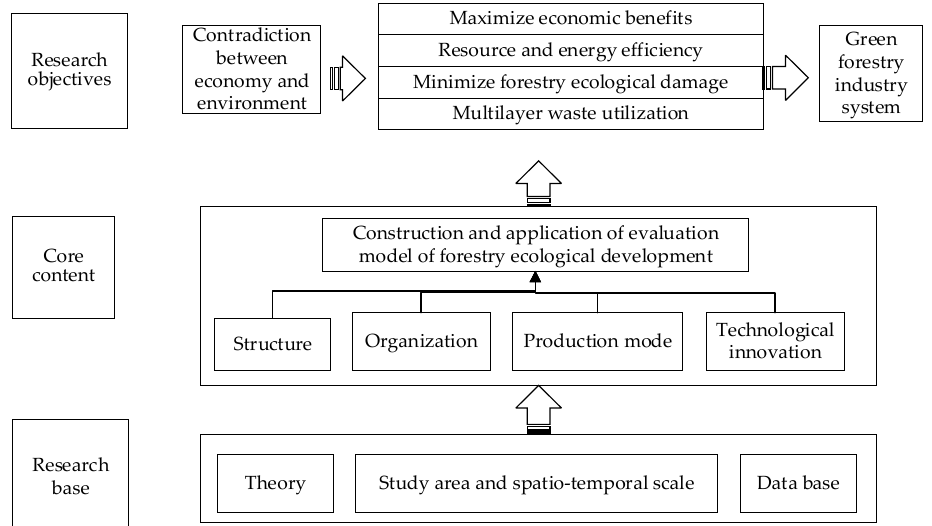
Figure 1. Conceptual framework of evaluation for forestry industry ecological development.